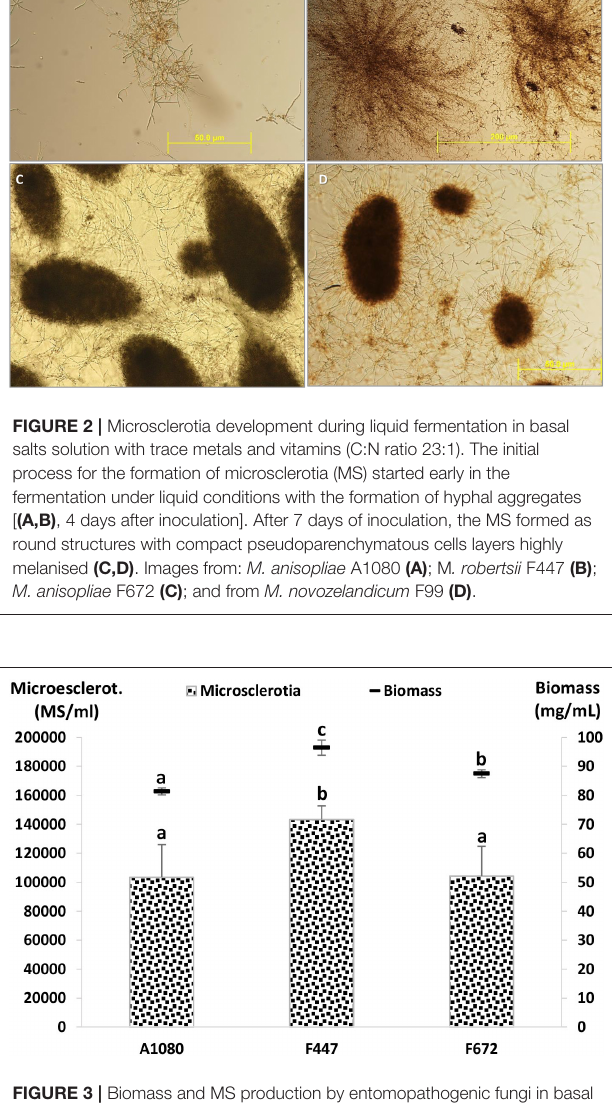
with the highest production achieved by M. anisopliae F 672 ( p < 0.01; Table 2